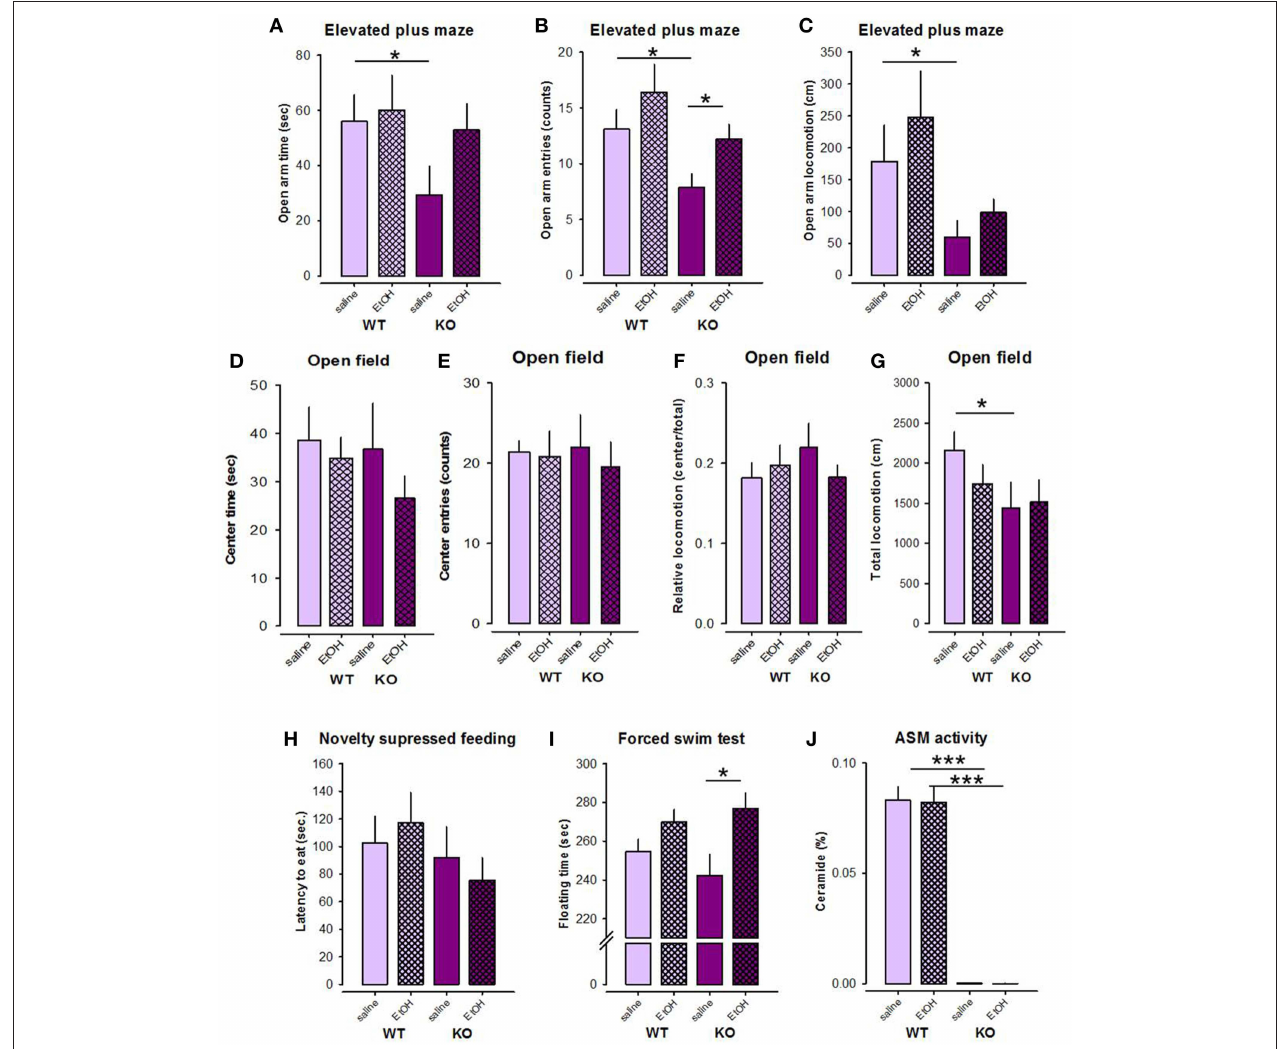
FIGURE 4 | Forced treatment with alcohol modeled by intraperitoneal injection with alcohol reduces anxiety level selectively in mice with acid sphingomyelinase deficiency (KO) as observed in the elevated plus maze (A–C) , but not in the open field test (D–G) . Alcohol injections do not affect the behavior of mice in the novelty suppressed feeding test (H) , but has depressogenic effect in KO mice in the forced swim test (I) . Forced treatment with alcohol does not affect acid sphingomyelinase (Asm) activity in the dorsal hippocampus of KO and wild type (wt) mice (J) . The error bars show the mean ± SEM (*** p < 0.001, * p < 0.05 vs. wt